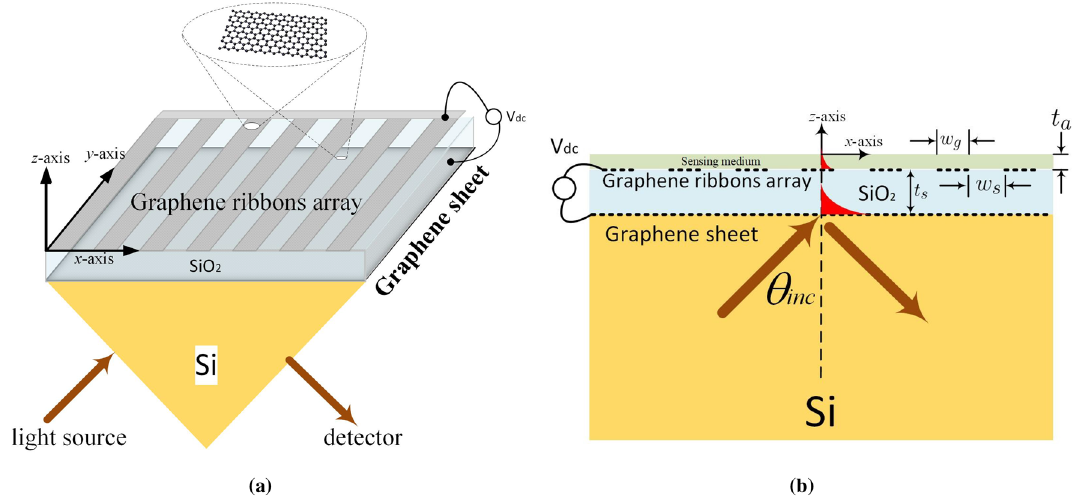
Figure 1. ( a ) Conceptual view of the evanescent wave biosensor, and ( b ) 2D model for electromagnetic full- wave